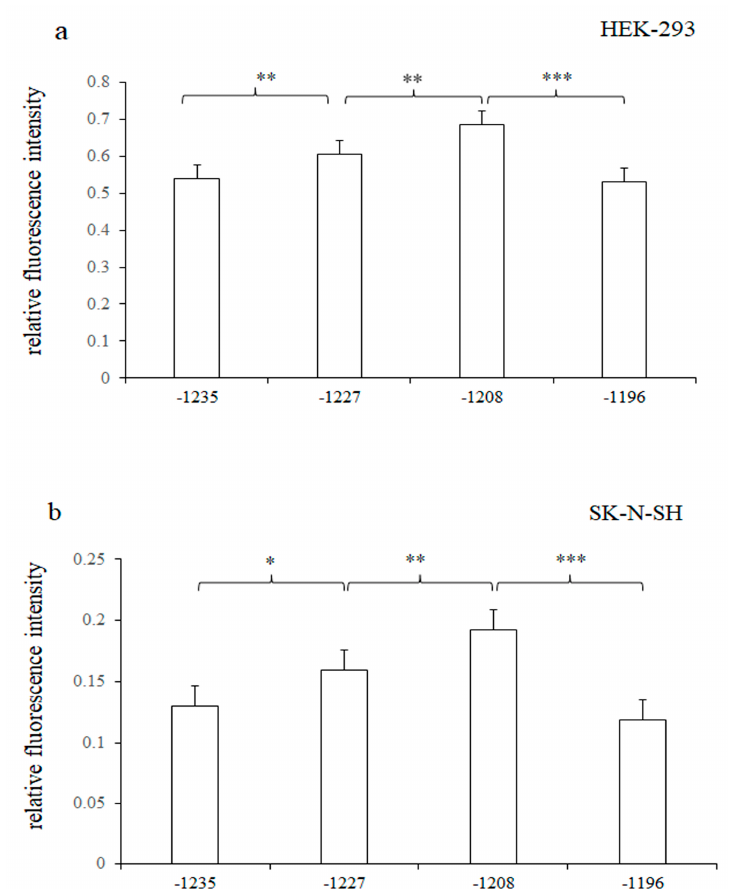
Figure 3. ( a )RelativefluorescenceintensityofpGL3-HTR1A-1235, pGL3-HTR1A-1227, pGL3-HTR1A-1208 Figure 3. Relative fluorescence intensity of pGL3-HTR1A-1235, pGL3-HTR1A-1227, pGL3-HTR1A-1208 and and pGL3-HTR1A-1196, ( b ) In HEK-293 and SK-N-SH cells, the relative fluorescence intensity of pGL3-HTR1A-1196 ( a ), ( b ) In HEK-293 and SK-N-SH cells, the relative fluorescence intensity of the adjacent